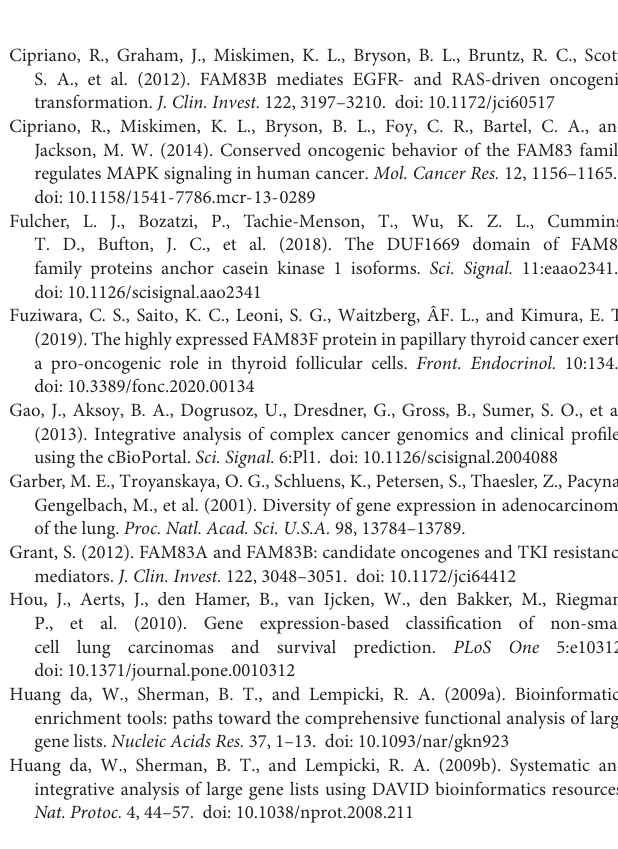
Supplementary Figure 1 | Q–Q graph and histogram were used to detect whether the sample data obeyed normal distribution. In Q–Q graph, X -axis is the normal distribution quantile and the Y -axis is the sample quantile ( A–K left). In the histogram, the X -axis is the equidistance segmentation range of gene expression value, the Y -axis is the sample proportion located in this region, and the red curve is the density fitting curve, and the purple curve is the normal distribution fitting curve ( A–K right). Supplementary Figure 2 | The scatter diagram is used to describe the relationship between p -value and cutoff. The X -axis represents the cutoff, the Y -axis represents the p -value, and the position shown in the arrow is the cutoff value corresponding to the p <